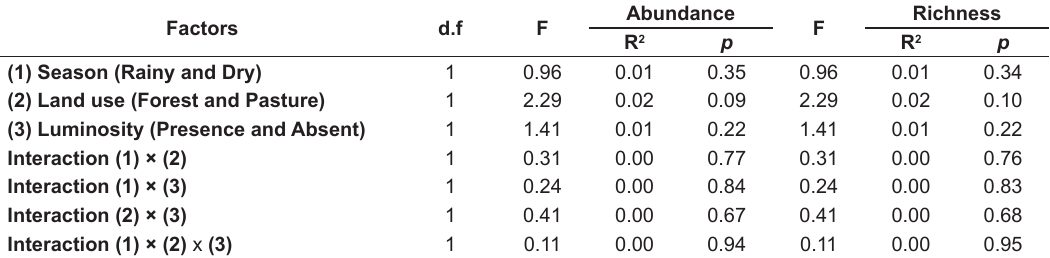
Table 5. PERMANOVA (Permutational Multivariate Analysis of Variance, Pseudo-F value) for fish assemblages in stream in the Machado River basin, July 2013 to May 2014.